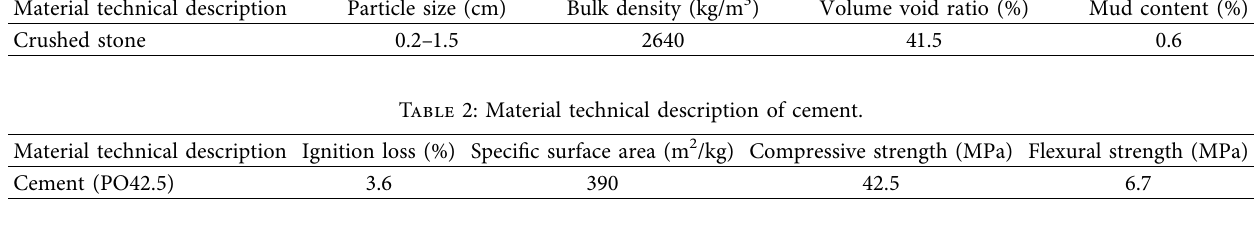
Table 3: Material technical description of steel